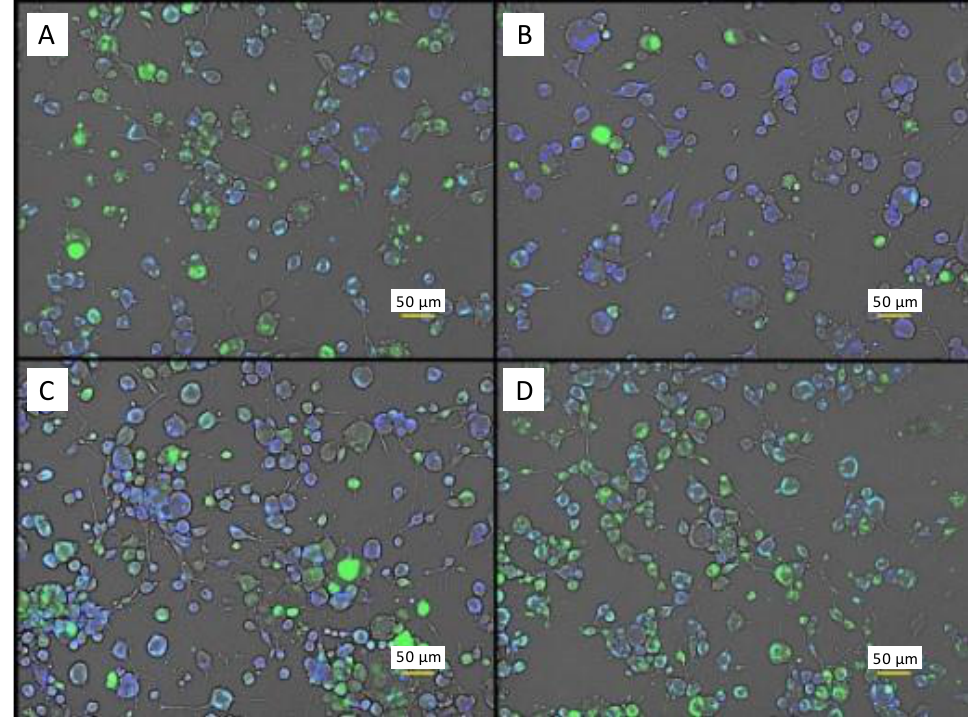
Figure 6. Fluorescence microscopy images of C6 glioma cells in the same plate in the presence of both 20 μM NO probe (DAF-FM, green) and 5 mM Cl − probe (MQAE, blue). Cyan color denotes coexistence of intracellular NO and Cl − . ( A ) PBS control cells. ( B ) PBS cells after ES. ( C ) 10 mM L-glutamate. ( D ) 250 nM adenosine. Scale bars are 50 µm.